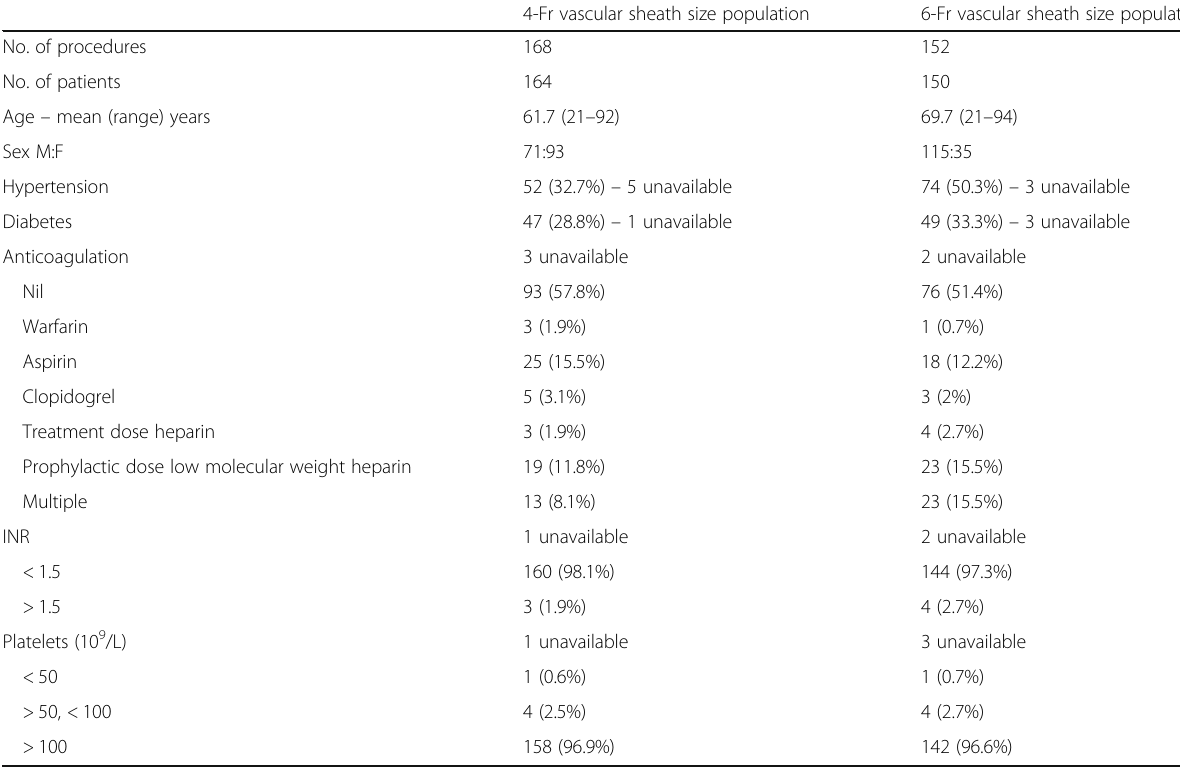
4-Fr vascular sheath size